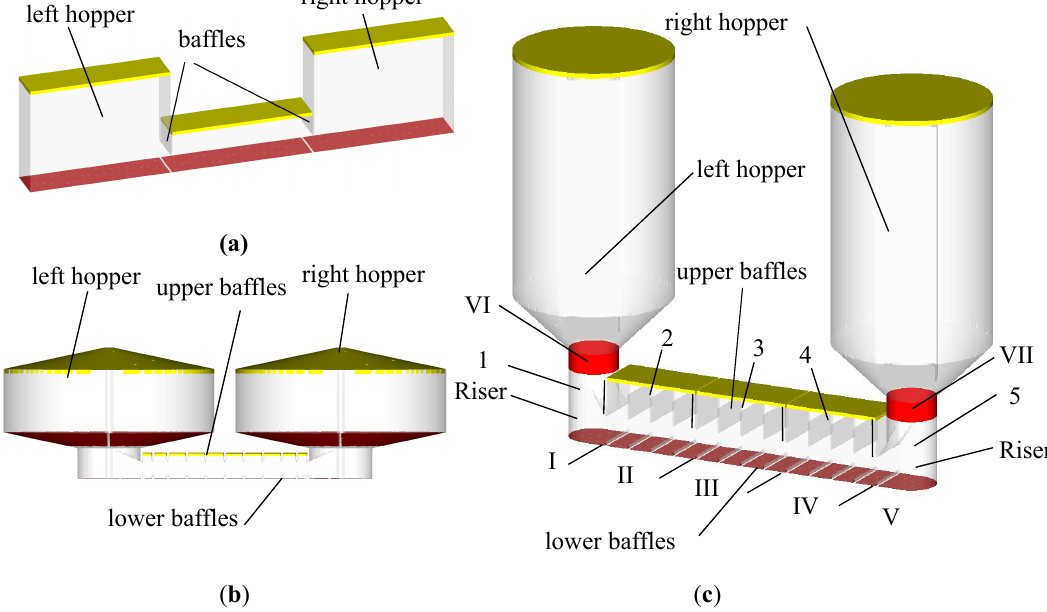
Figure 2. ( a ) First simplified FP-TES geometry, ( b ) improved simplified geometry and ( c ) advanced geometry of FP-TES for detailed simulations with yellow areas representing pressure boundary conditions and red areas representing flow boundary